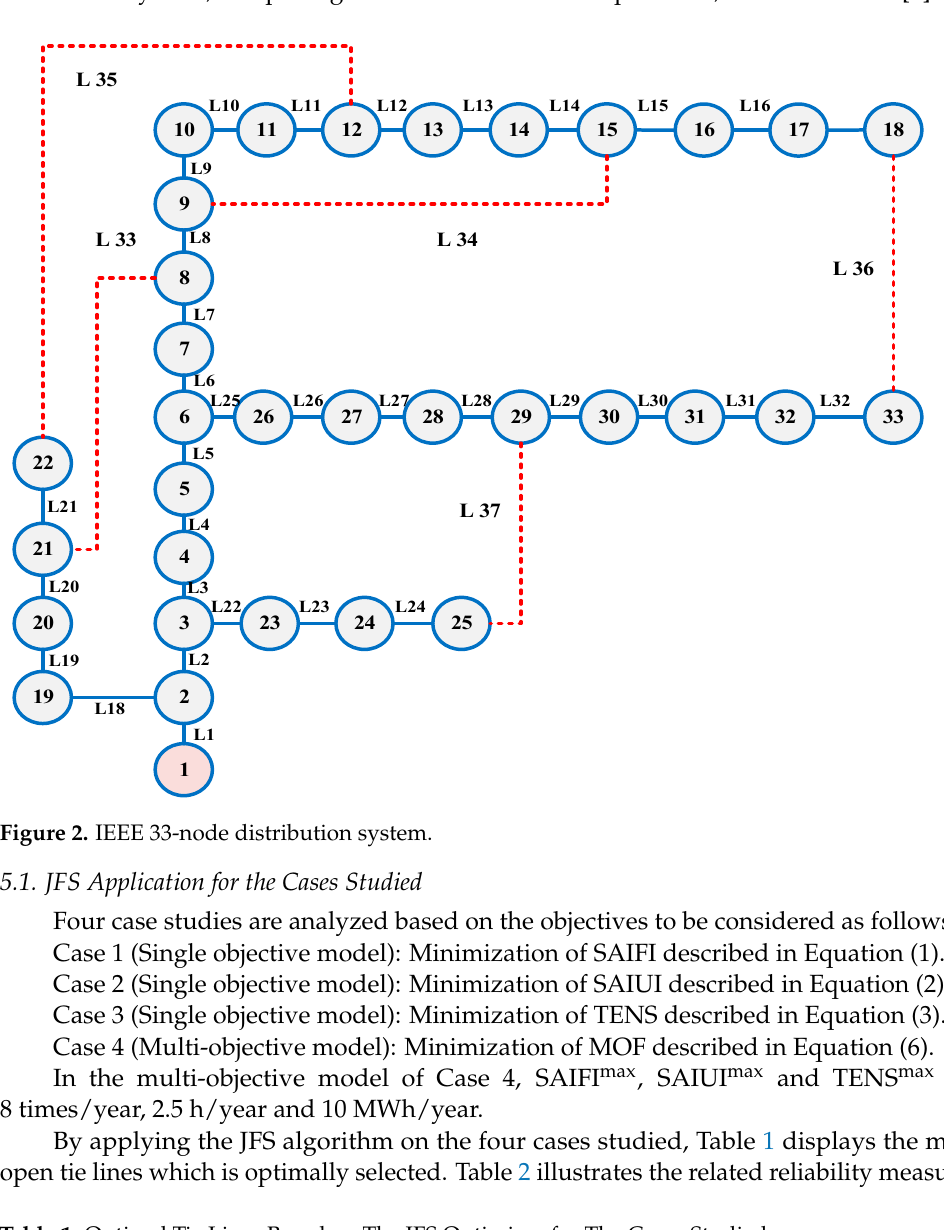
Table 1. Optimal Tie Lines Based on The JFS Optimizer for The Cases Studied.